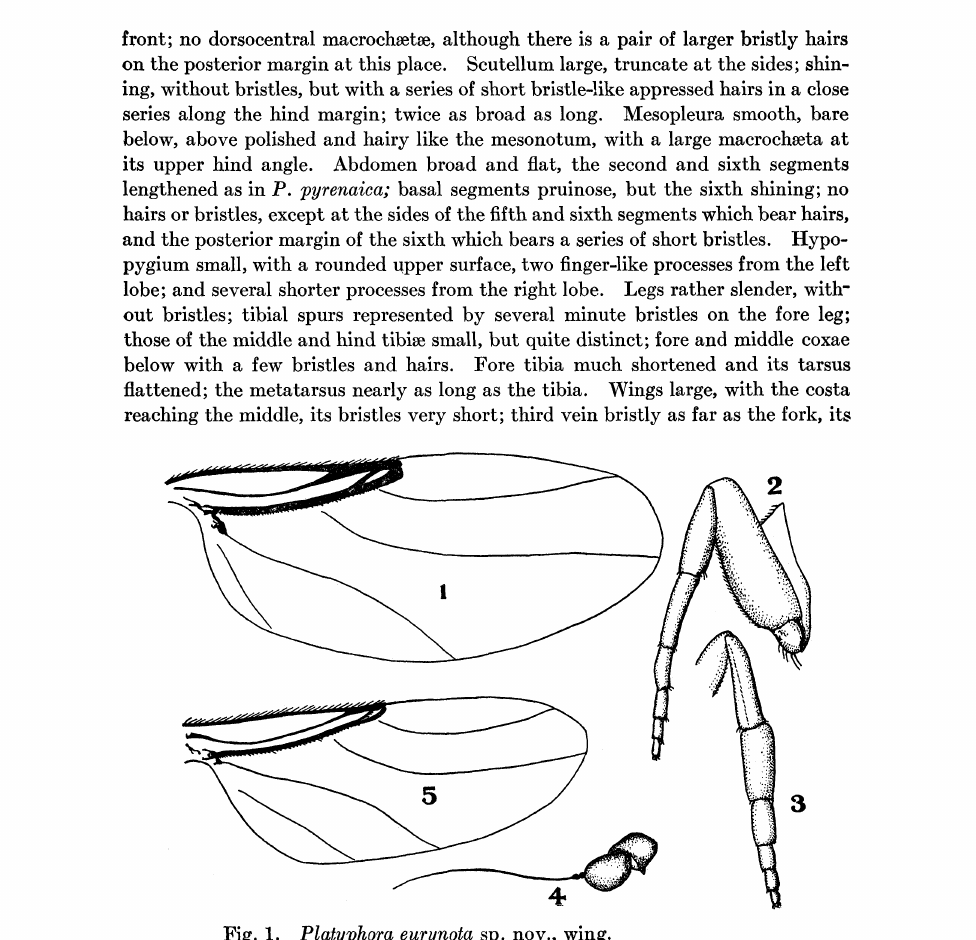
. Fig. 1. Platyphora eurynota sp. nov., wing. Front leg of same side view. 3. Front tibia and tarsus of same, external view. 4. Antenna of same. 5. Platyphora coloradensis sp. nov.,